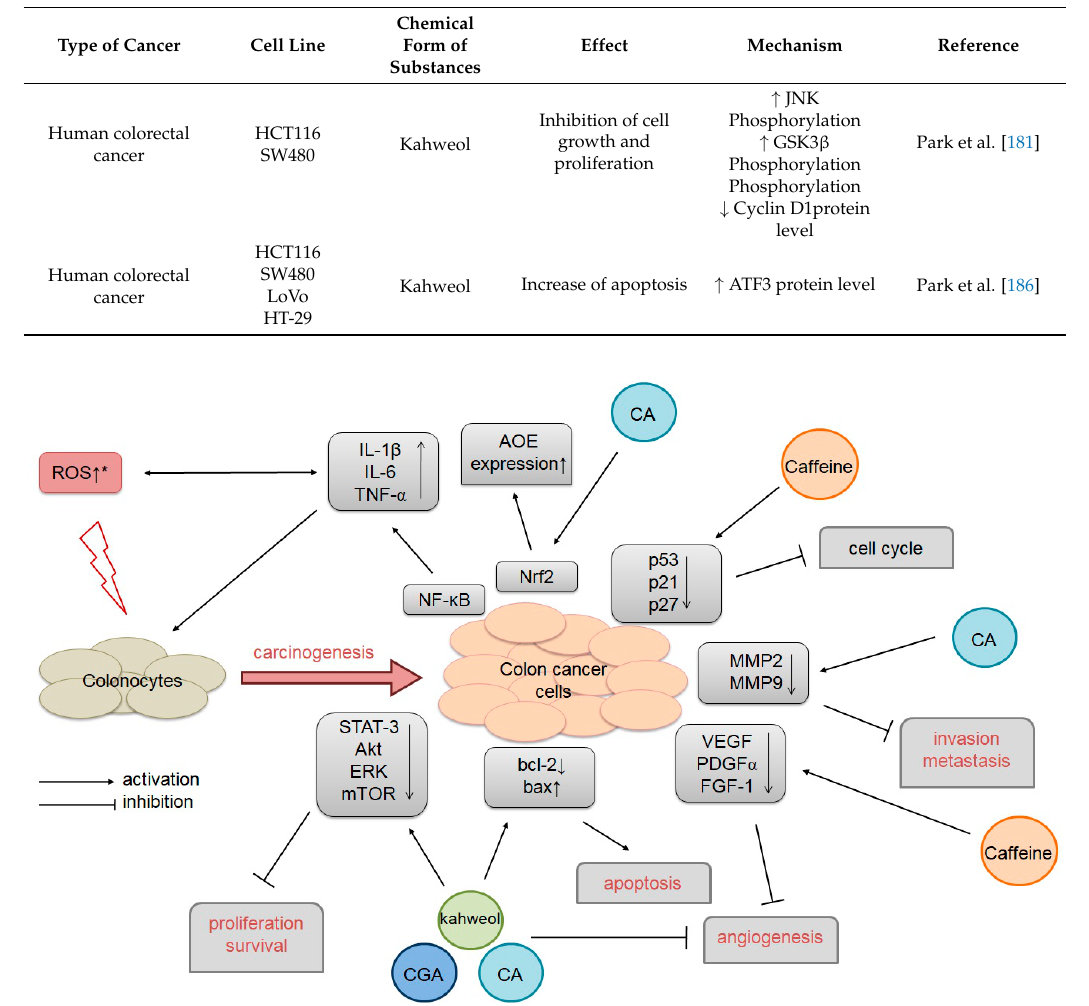
Figure 2. The potential mechanism of caffeine and nonflavonoid catecholic compound influence on colorectal cancer. (*) ROS leads to spontaneous goblet cell dysfunction, impaired mucosal barrier function, and inflammation, and exacerbates the development of pathology (such as cancer). CA: Caffeic acid; CGA: Chlorogenic acid.